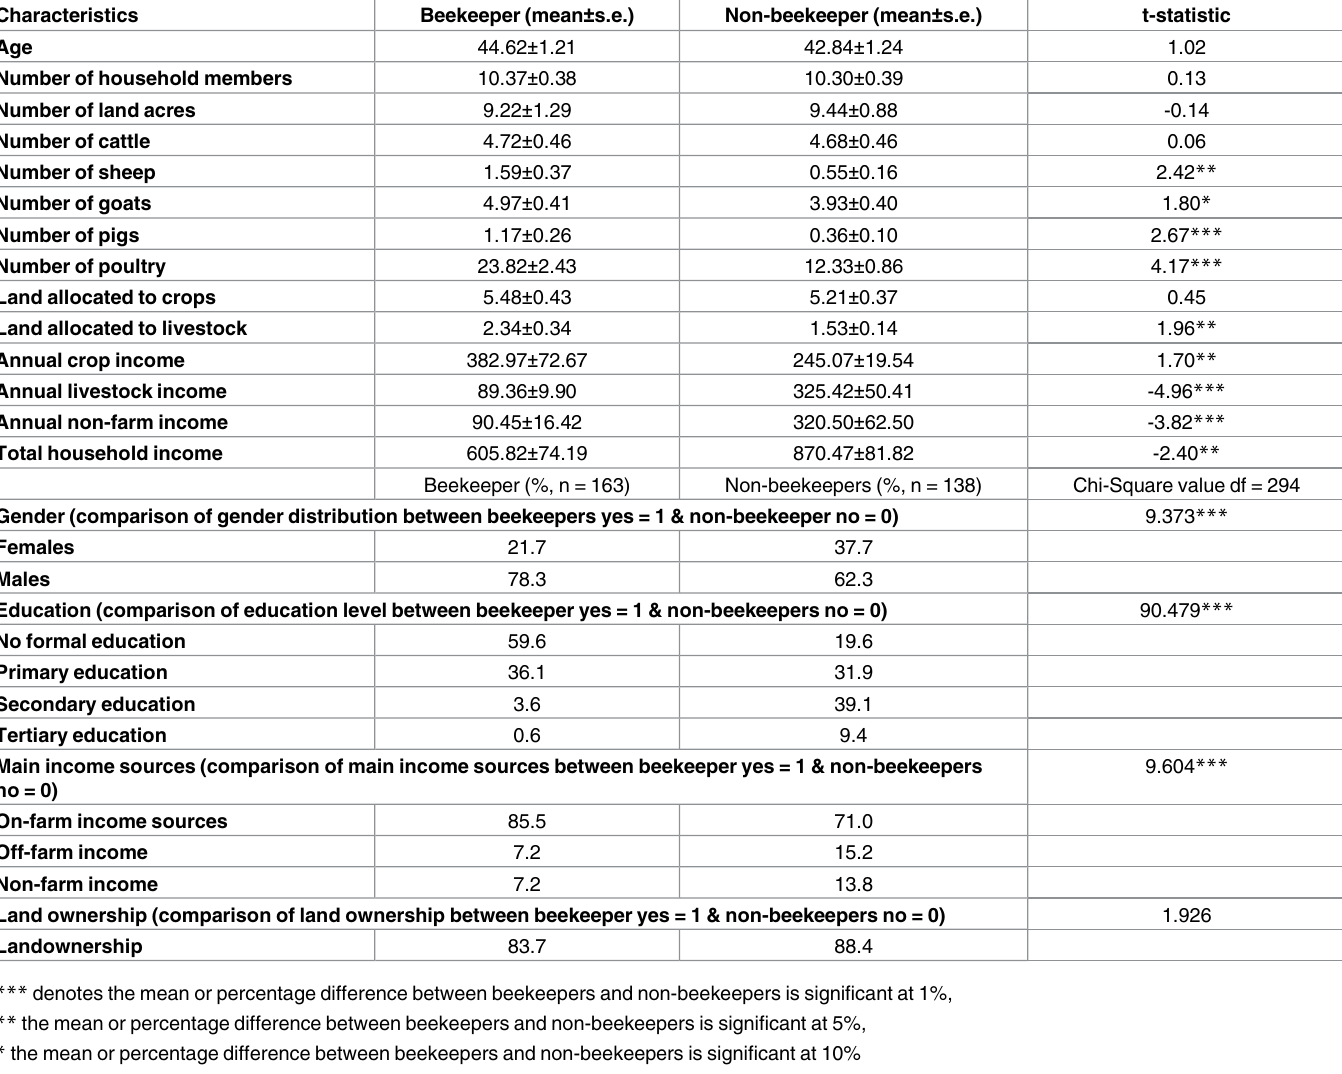
Table 2. Socio-demographic characteristics of households as measuredwith continuous and categorical